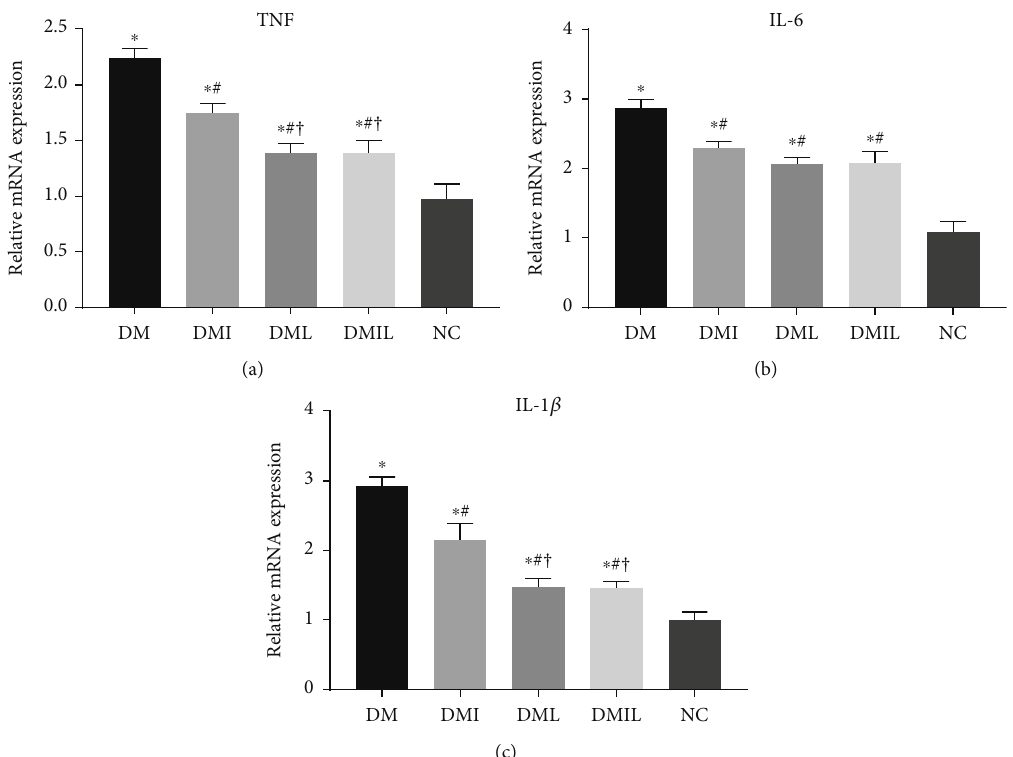
Figure 4: E ff ects of liraglutide on relative mRNA expression of (a) TNF, (b) IL-1 β , and (c) IL-6. Data are expressed as mean ± SD ( n = 4 /group); p < 0 : 05 was de fi ned as statistically signi fi cant. DM: saline-treated type 1 diabetes group; DMI: insulin treatment group; DML: liraglutide treatment group; DMIL: insulin+liraglutide treatment group; NC: normal glucose tolerance group; ∗ : compared to NC; #: compared to DM; † : compared to DMI; ‡ : compared to